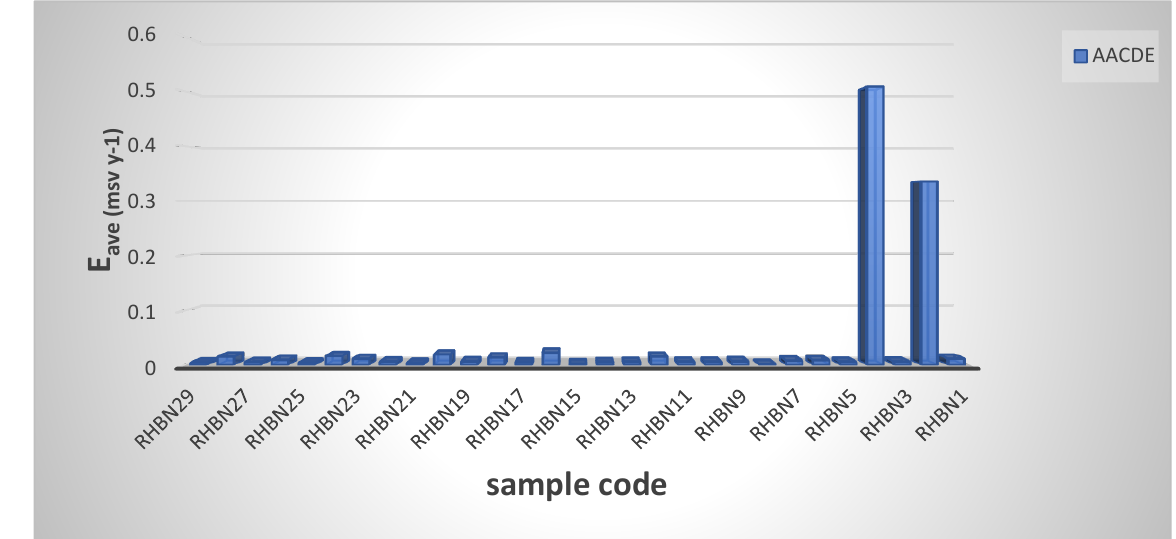
Figure 8. The average annual committed effective dose (Eave) distribution in the various species of the medicinal plant samples. Table 5. Comparison between AACED ingestion dose of the present medicial plant samples with that of other countries of the world. Country AACED